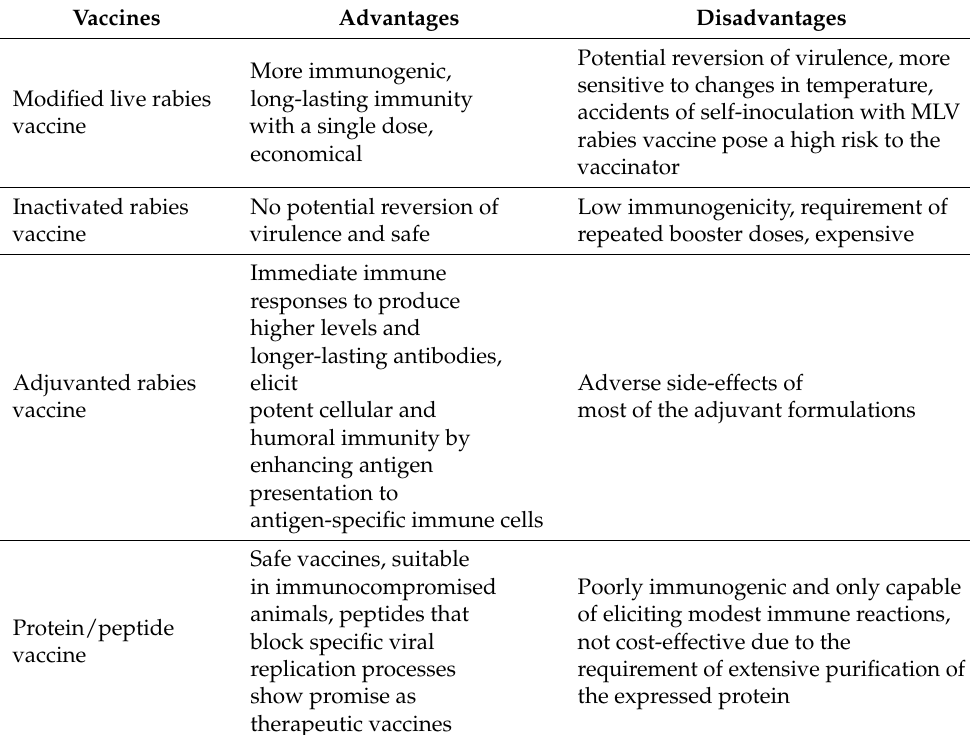
Table 2. Advantages and disadvantages of current rabies